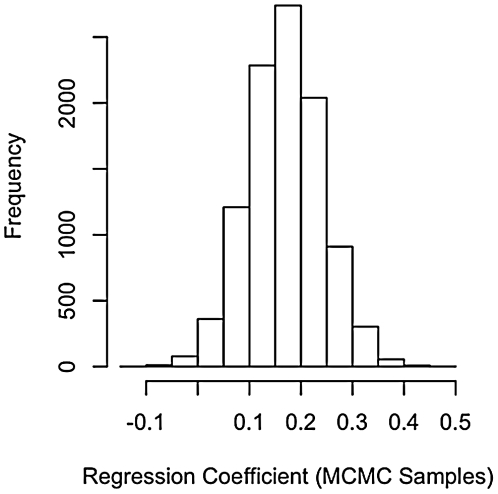
Regression coefficients relating estrous overlap to the number of males.The distribution of regression coefficients was obtained from the MCMC analysis. Note that most coefficients sampled are larger than zero, providing strong support for an association between these two variables.